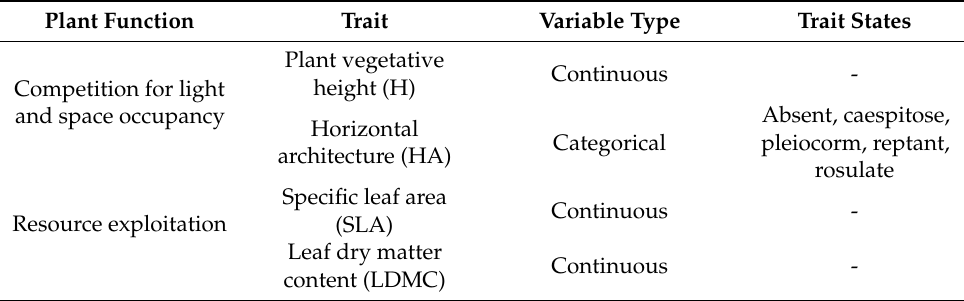
Table 1. List of the considered plant traits, variable type, and states of categorical traits. Plant Function